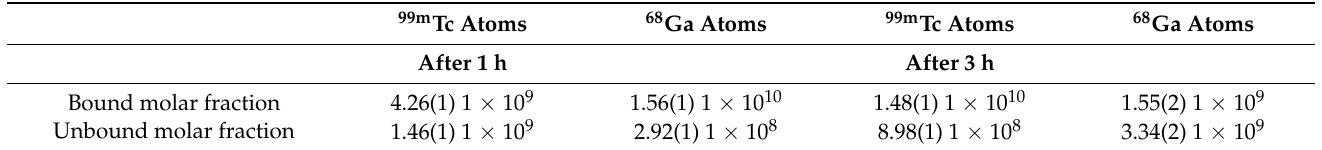
Table 4. 99m Tc and 68 Ga amount bound/unbound to MAA, reported as molar fraction (Mean (SD)). 99m Tc Atoms